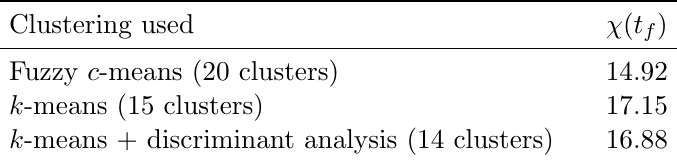
Table 1: Table of χ ( t f ) values for various